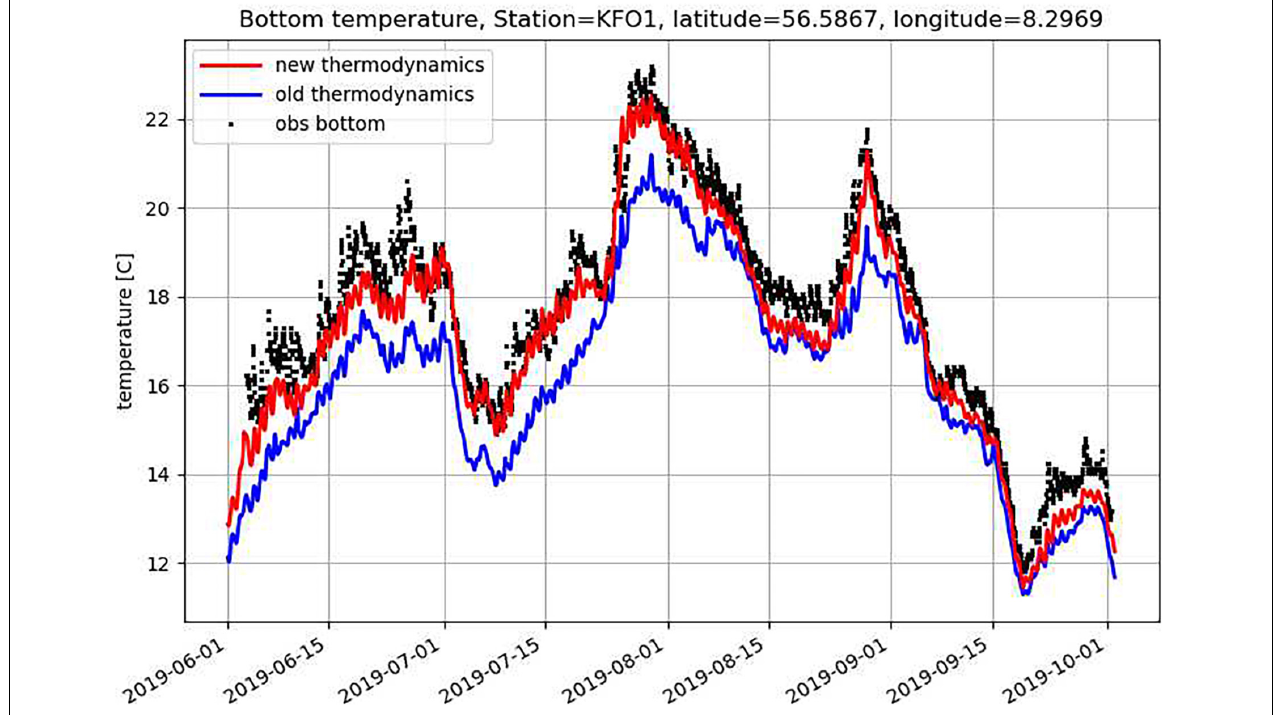
FIGURE 5 | Impacts of the shallow water radiation scheme on the HBM model prediction of near surface temperature: Observations (black dotted), model with previous surface radiation scheme (blue) and improved surface radiation scheme (red).